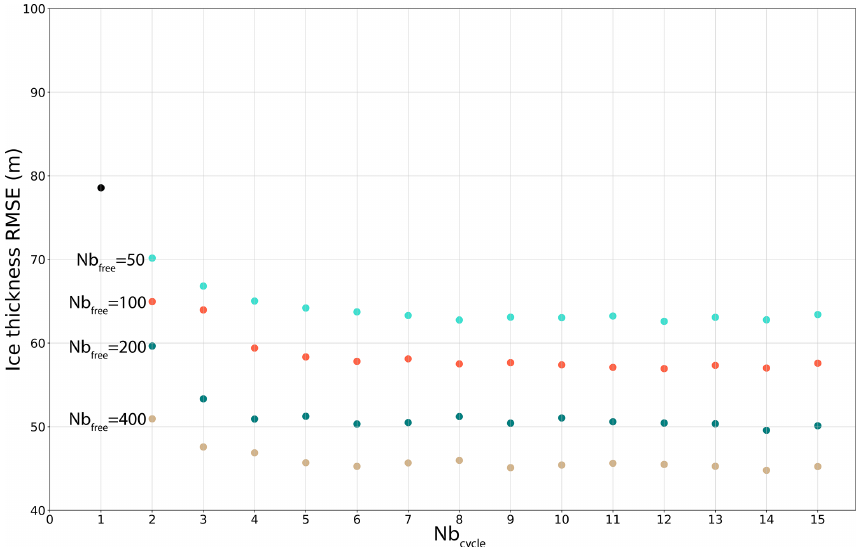
Figure 14. Ice thickness root mean square error with regard to observations from Bamber et al. (2013), in metres, for a fixed Nb inv = 20 and four Nb free values (50, 100, 200, 400), as a function of the number of iterations (Nb cycle ). The experiments use an enhancement factor of